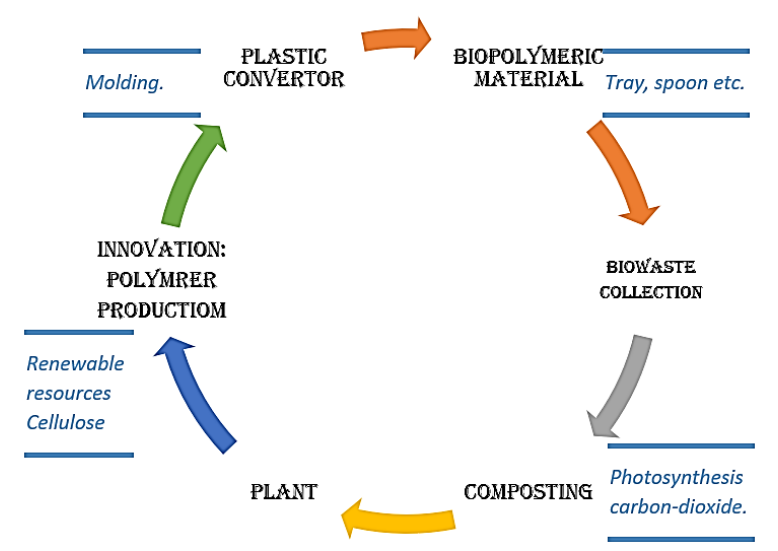
Figure 5. Carbon dioxide (CO 2 ) sequestration for composite fabricated from renewable source.